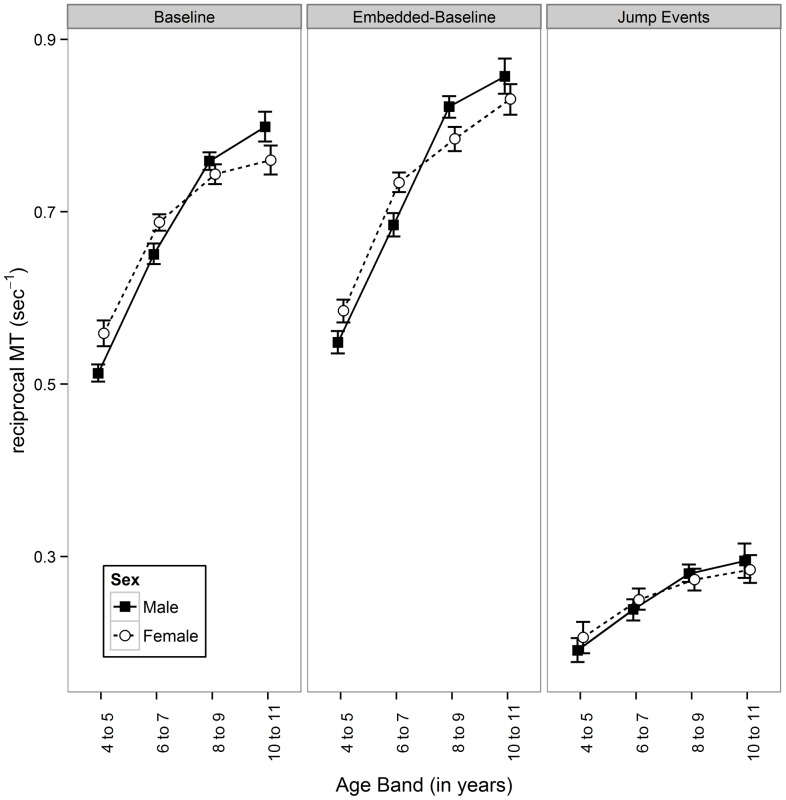
Line-graph of reciprocal movement time (MT) by Age-Group, Sex and Experimental Condition.Reciprocal MT (sec−1) is a measure of average time to move from one target to the next in a serial aiming task. In normal Baseline and Embedded-Baseline trials Female participants had a statistically significant advantage over males in the younger age-groups, with this crossing over in the older age-groups (i.e. no sex differences or a male advantage dependent on age-group and Condition). Meanwhile, no significant differences between sexes were observed, irrespective of age, for ‘Jump’ aiming movements that required additional online corrections. This was reflected in statistical analysis finding a significant 3-way interactions between Age-Group, Sex and Condition (p<.05). Note: Point estimates and associated 95% confidence Intervals for each sex group within an age-group have been artificially moved on the horizontal axis so that they display side-by-side, preventing overlaps obscuring interpretation.